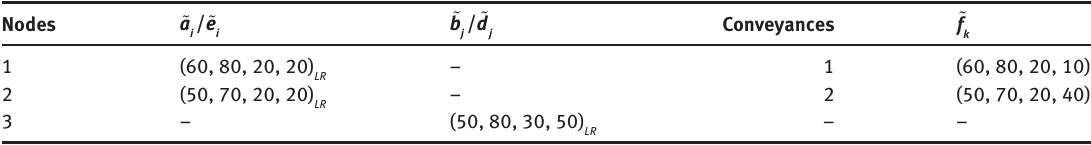
a e (cid:31) (cid:31) Fuzzy Demand ( / ), i i